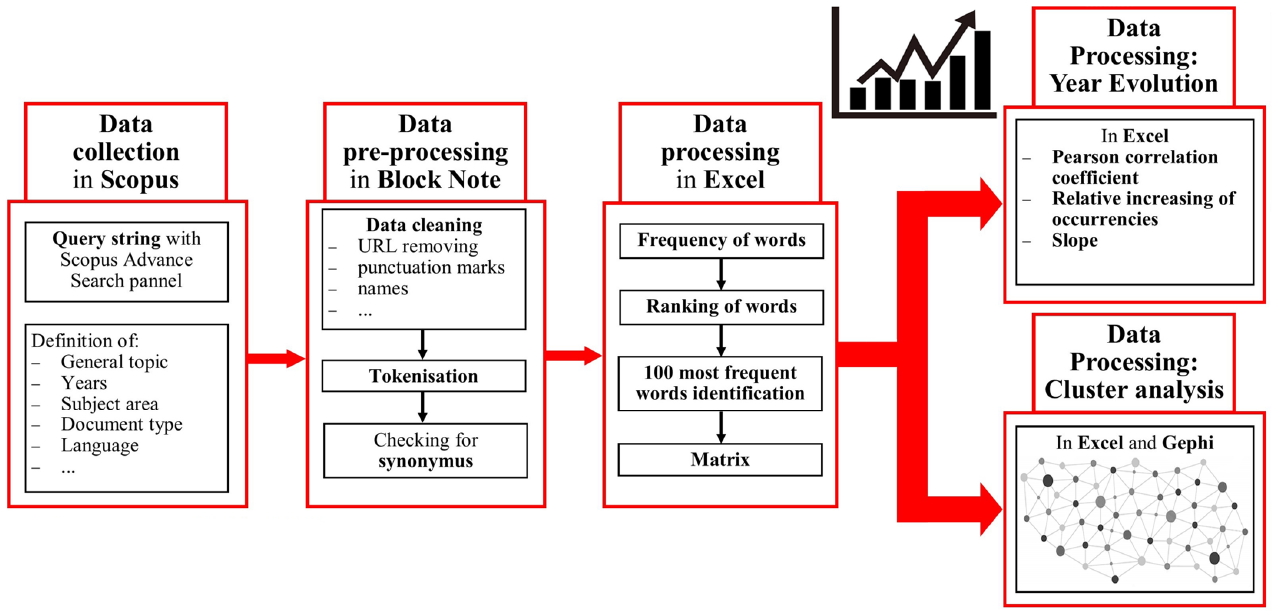
Figure 1. Scheme of the whole analysis process of the text data.